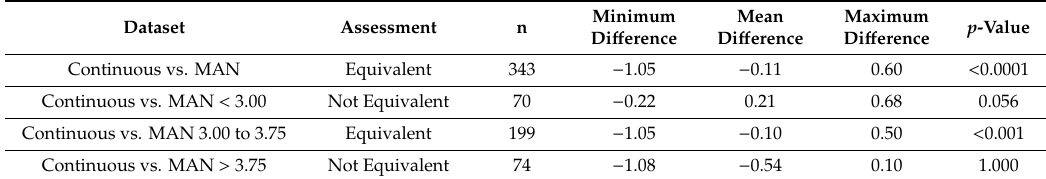
Table 2. Regression analysis of cattle body condition scores (scale 1 to 5, low to high, n = 343) for automated continuous and categorical (low = body condition scoring (BCS) < 3.0, normal = BCS 3.0